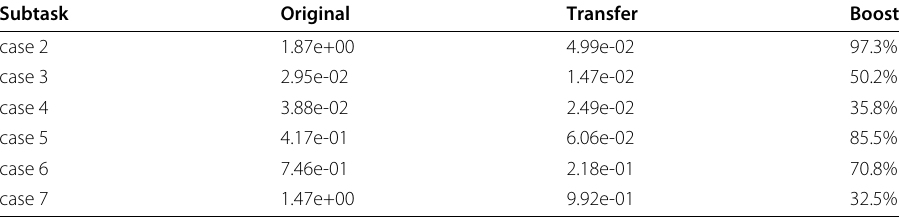
Table 2 Performance boost of PINN-anneal on the Helmholtz benchmarks using transfer learning Subtask Original